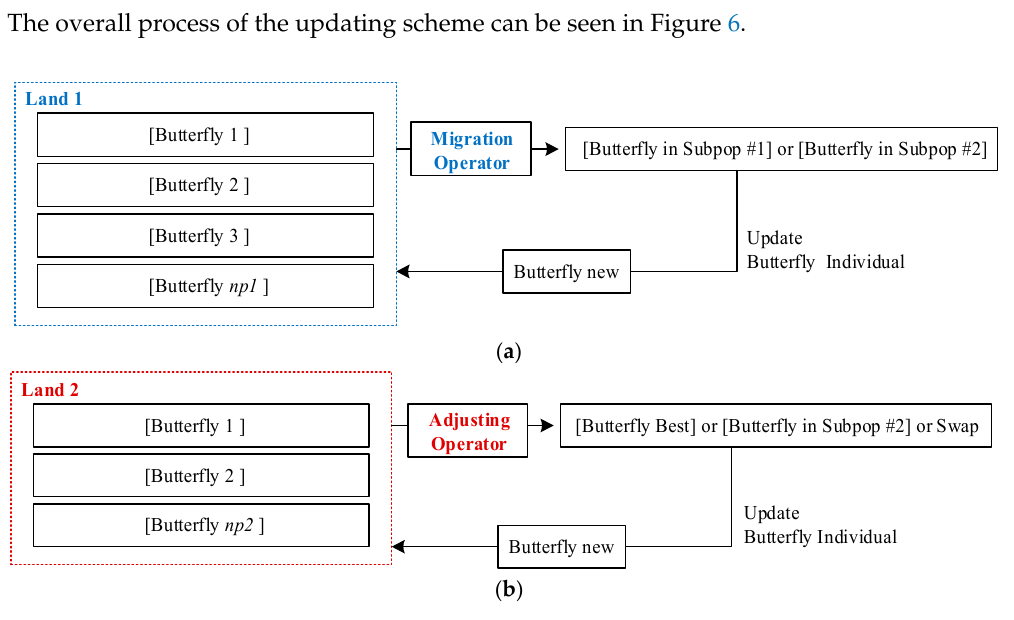
Figure 6. Updating process of MBO. ( a ) Migration operator; ( b ) Butterfly adjusting operator.